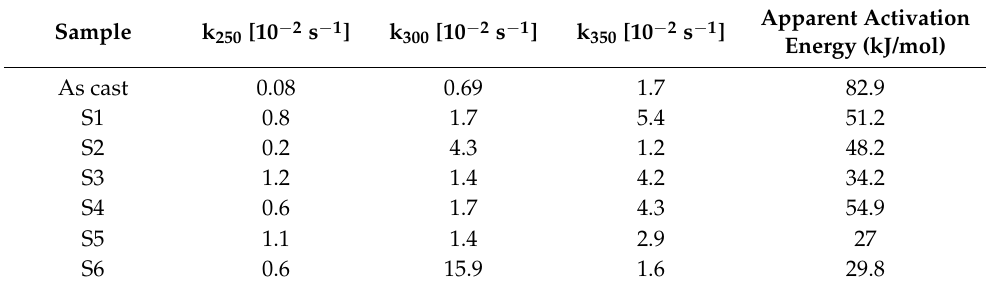
Table 5. Kinetic rate constants of the JMA model for the hydrogenation at different temperatures and apparent activation energy of the hydrogenation for different